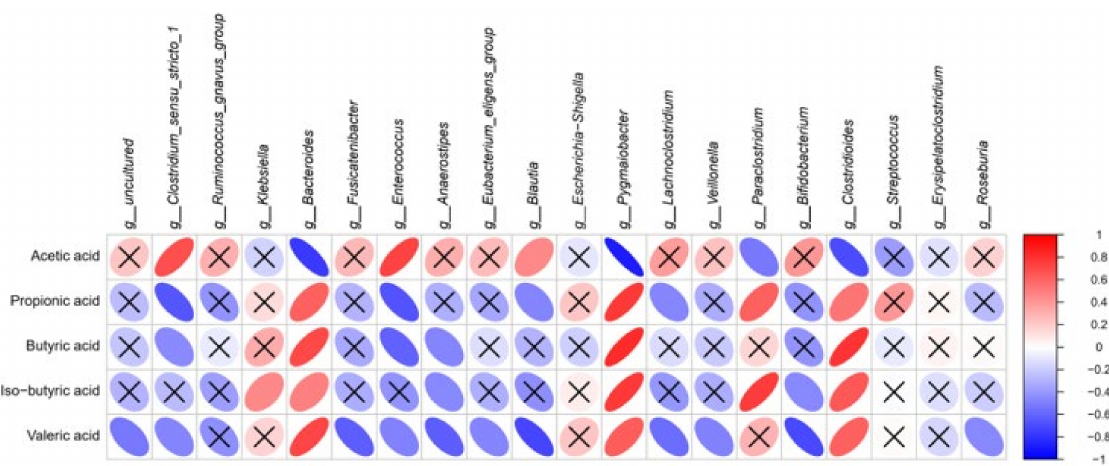
Figure 6. Spearman’s correlation analysis of SCFAs contents with microorganisms. × The insignifi- cant correlation ( p > 0.05); g,